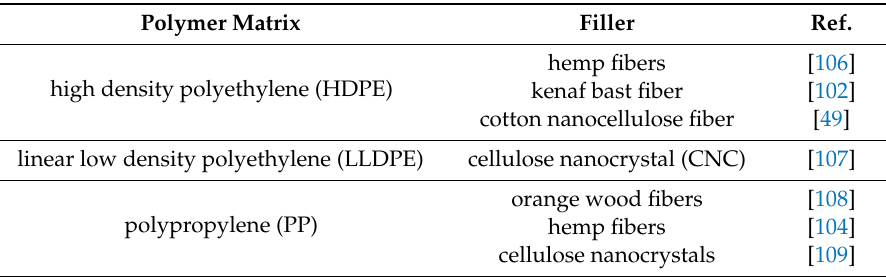
Table 4. Dynamic mechanical analysis of polyolefin composites filled with natural fibers.